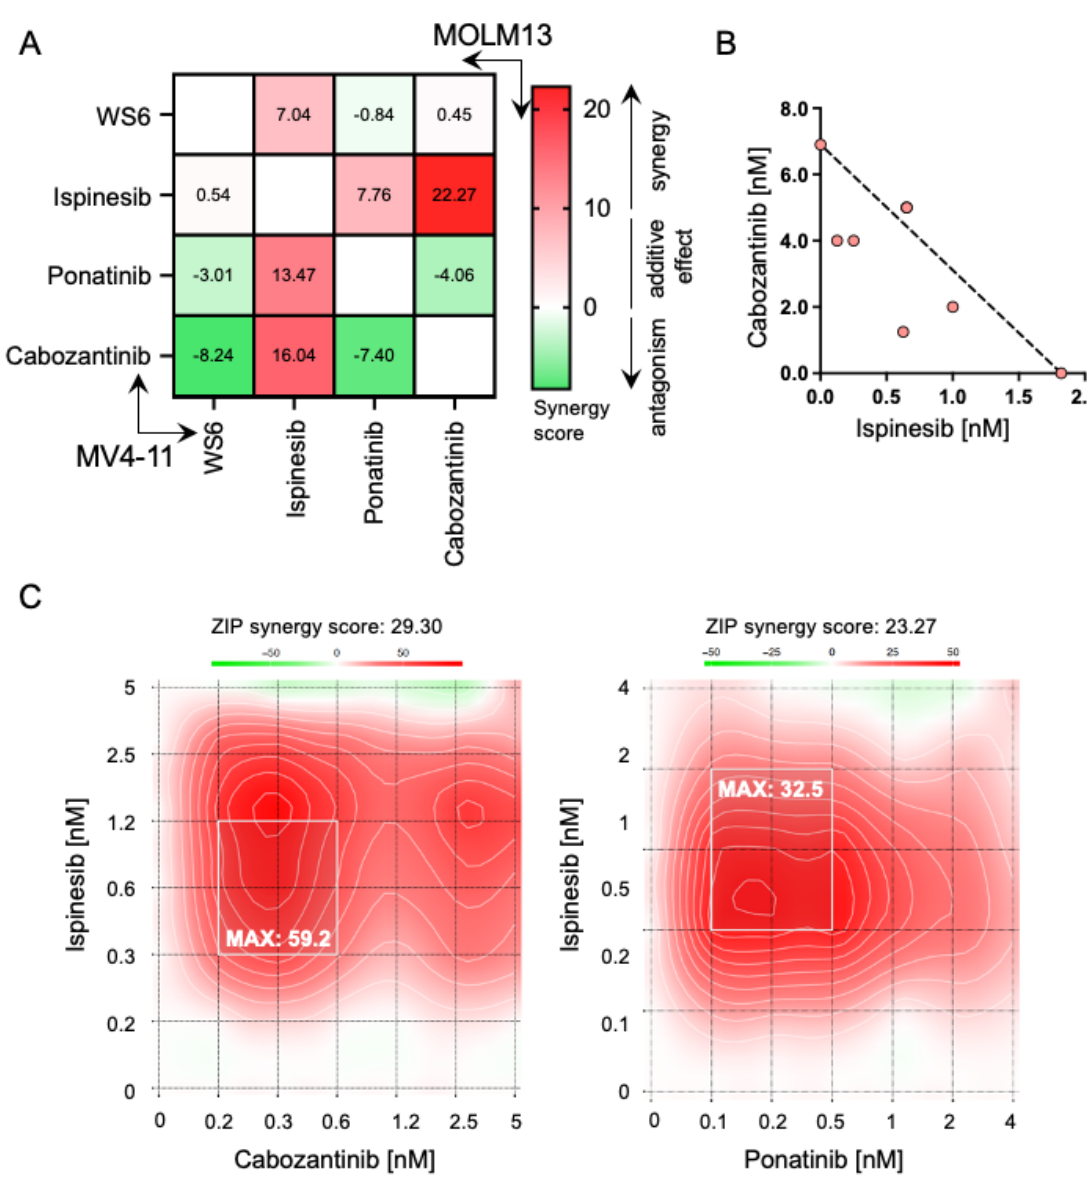
Figure 5. Interaction landscape of compounds with non-overlapping targets reveals an improved targeting impact. ( A ) Heatmap summarizing average ZIP scores of the synergy experiments between WS6, ispinesib, cabozantinib and ponatinib in MV4-11 and MOLM13, n = 3. ( B ) Isobologram of the ispinesib and cabozantinib interaction in MV4-11 cell line. ( C ) Representative interaction landscape between ponatinib or cabozantinib and ispinesib in MV4-11. The most synergistic area is shaded and the maximum synergy score is indicated. ZIP stands for Zero interaction potency, n = 3.